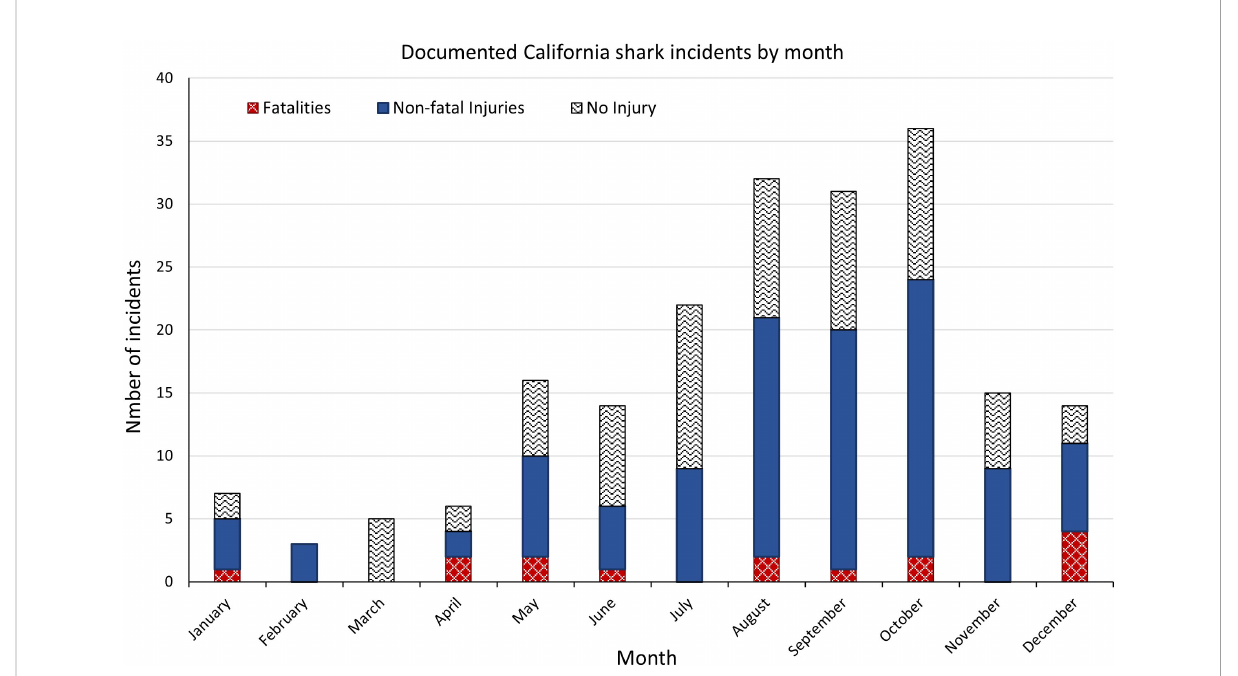
FIGURE 4 Documented California shark incidents by month and category: non-injury incidents, non-fatal injuries, and fatalities, 1950 to